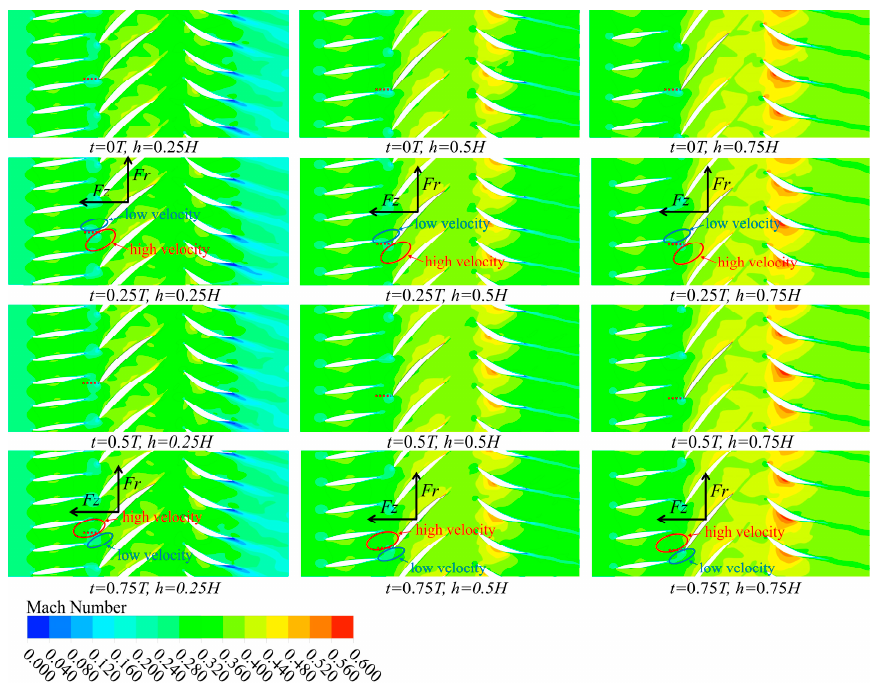
Figure 13. Mach number distribution of the 𝑎 = 5 mm model under design conditions.